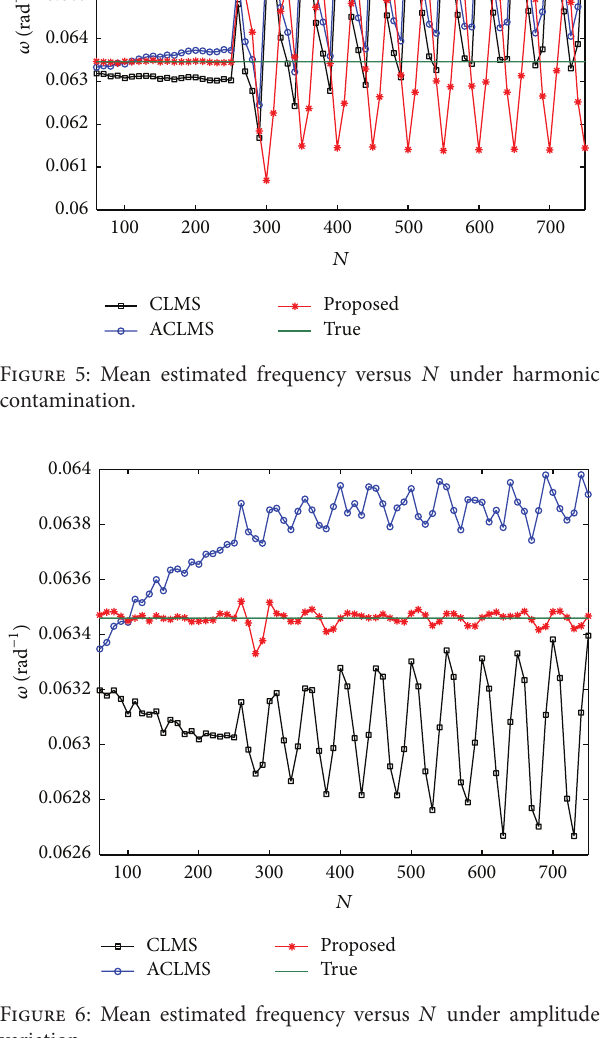
Figure 4: Mean estimated frequency versus 𝑁 in unbalanced sys- tem.